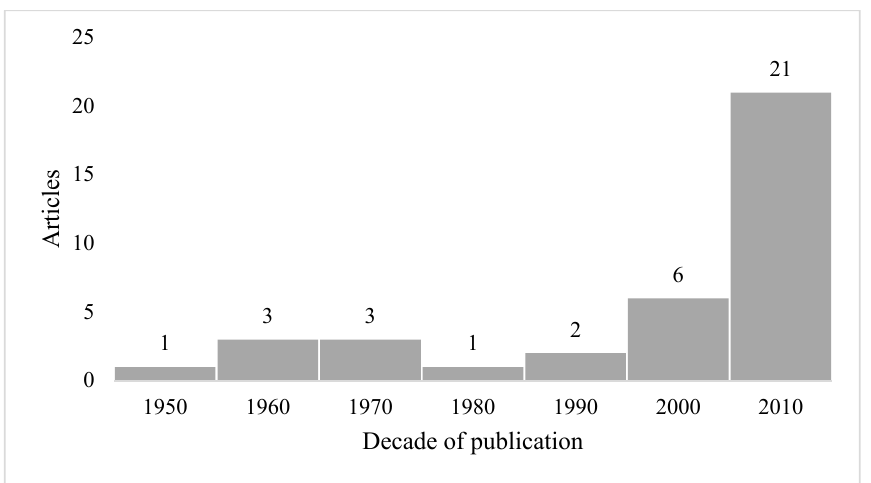
Figure 1. Articles on the heights of Colombian children and adolescents reviewed in this paper by decade of publication. Source: Created by the authors.